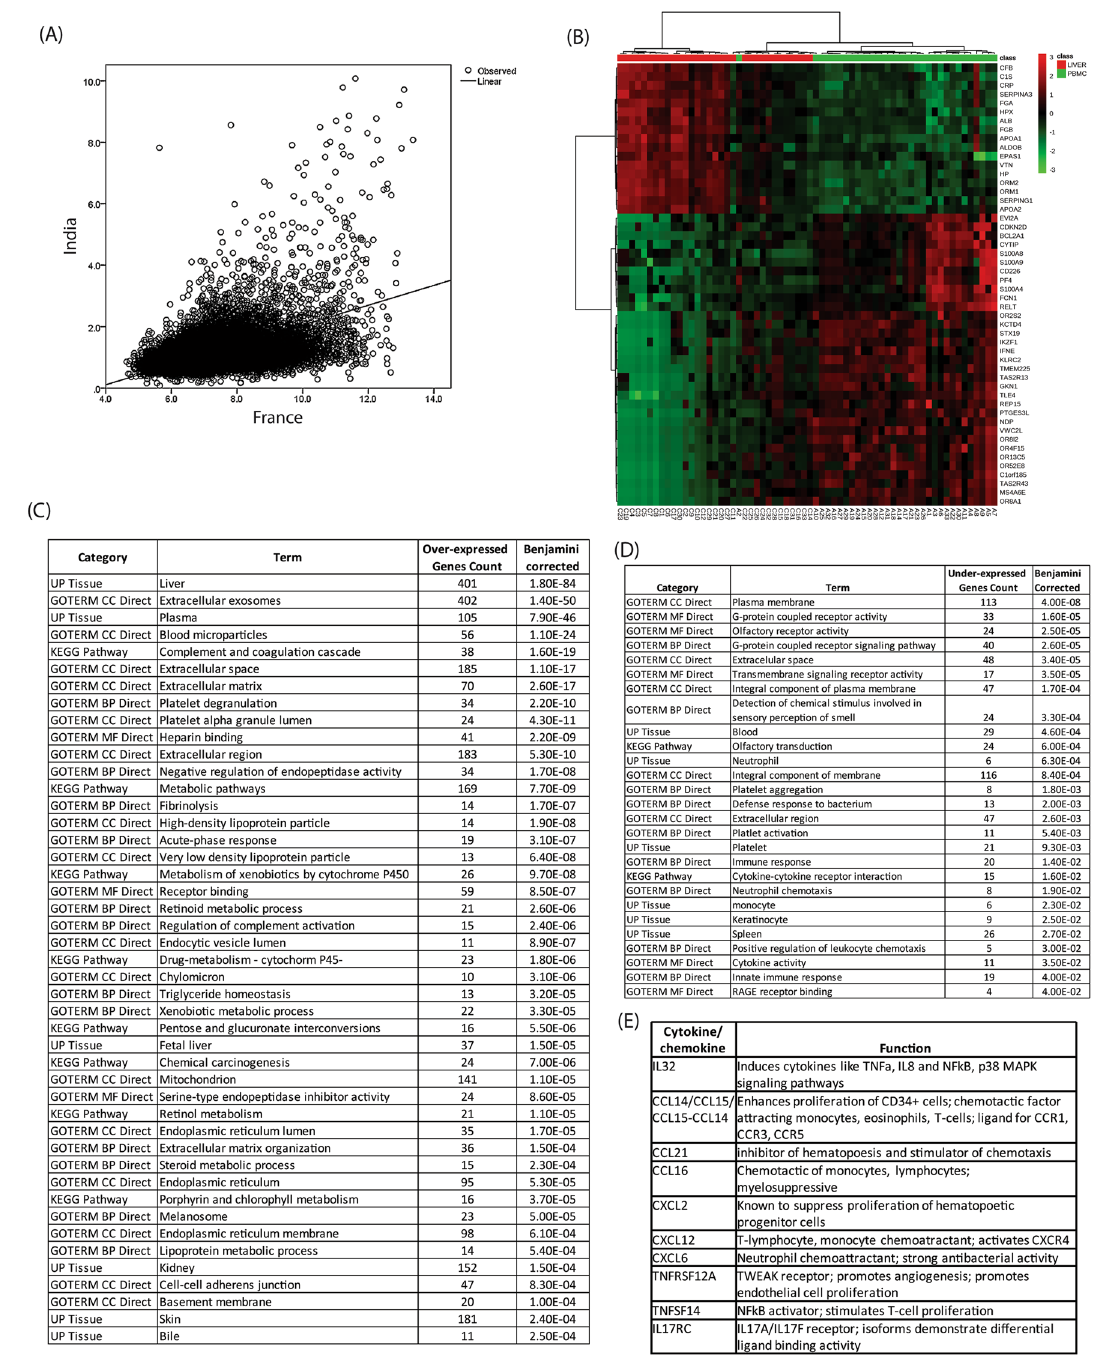
Figure 1. Comparative analysis of liver and PBMC identify common and distinct signatures in Indian and French SAH patients. ( A ) Correlation of baseline hepatic gene expression by microarray and RNA-Seq in French and Indian series, respectively ( r s = 0.374, p < 0.0001). ( B ) Heatmap based on top 50 differentially expressed genes between livers and PBMCs in Indian cohort. Enrichment analysis of DEGs that were over- expressed ( C ) and under-expressed ( D ) between the two tissues. ( E ) Cytokines/chemokines that were over expressed and were common between the two cohorts of